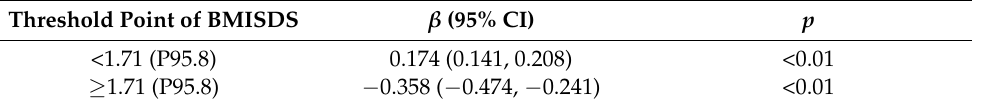
Table 3. Threshold effects of IGF-1SDS with BMISDS were analyzed using linear regression. Threshold Point of BMISDS